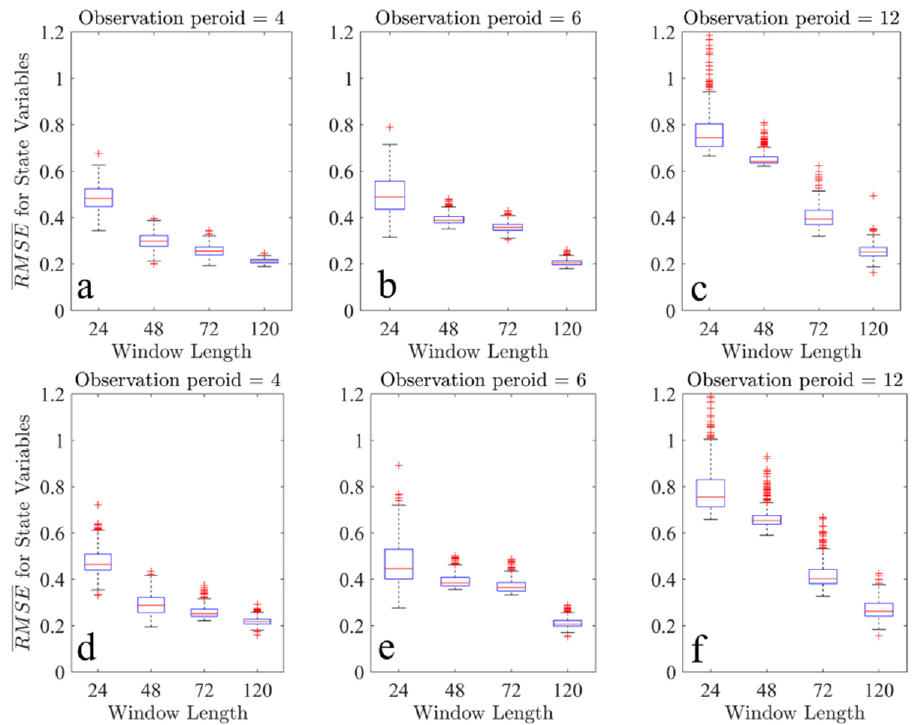
Figure 4. The effect of assimilation window lengths and observation periods on the RMSE for state variables. ( a ), ( b ) and ( c ) the box plot for A-4DEnVar and ( d ), ( e ) and ( f ) for 4DVar. The outliers are marked as red +.